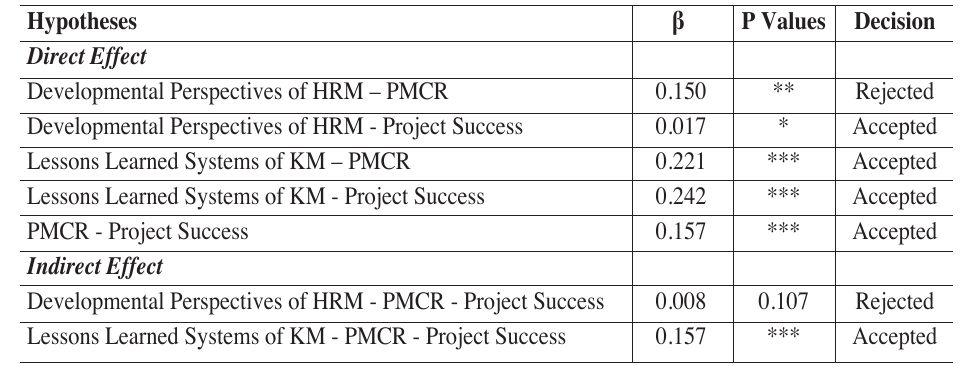
Table 4: Standardized Estimate of Path